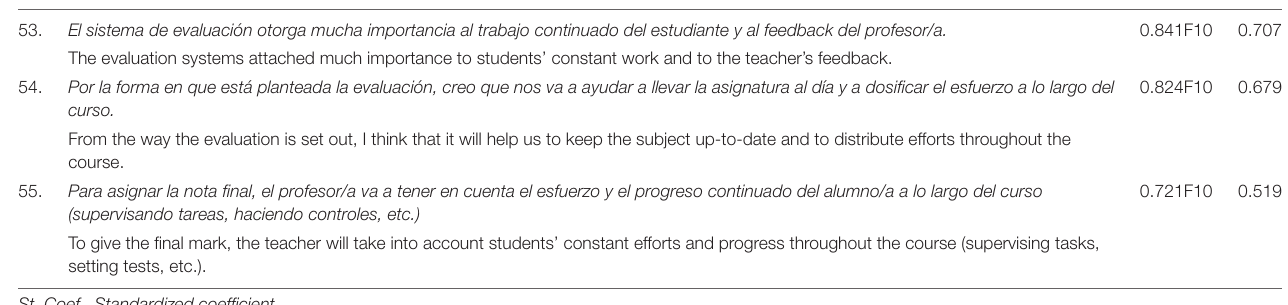
TABLE 4 | Student’s t -test for gender